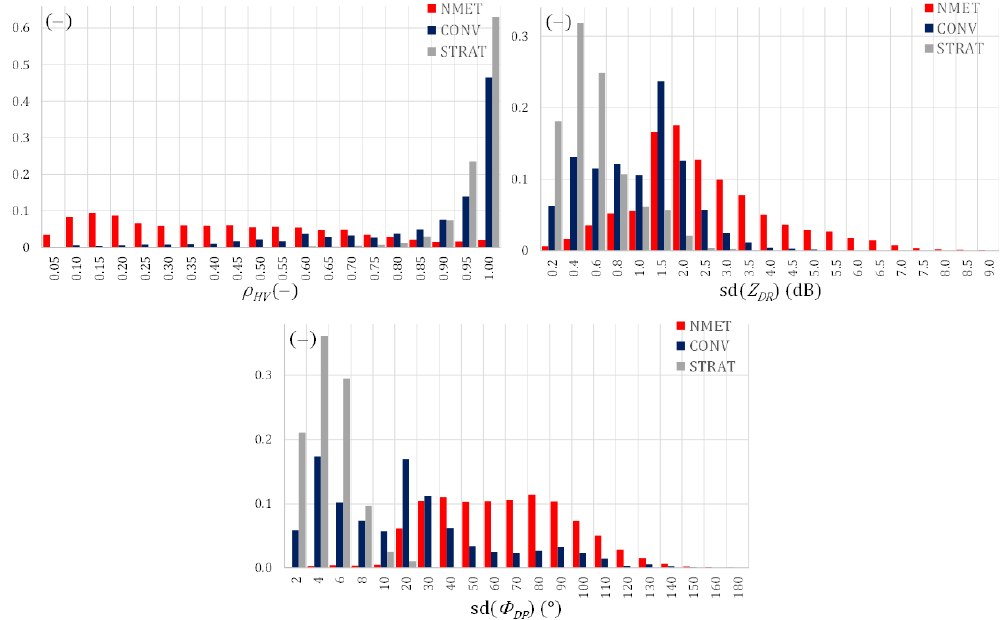
Figure 2. Histograms for selected polarimetric parameters from the top left – ρ HV , SD (Z DR ) , and SD ((cid:56) DP ) – for three classes of radar echoes: non-meteorological (NMET; in red), meteorological convective (CONV; in navy), and meteorological stratiform (STRAT; in grey). Ram˙za radar, data from 2d (1 September 2018 and 21 February 2019), the lowest elevation.